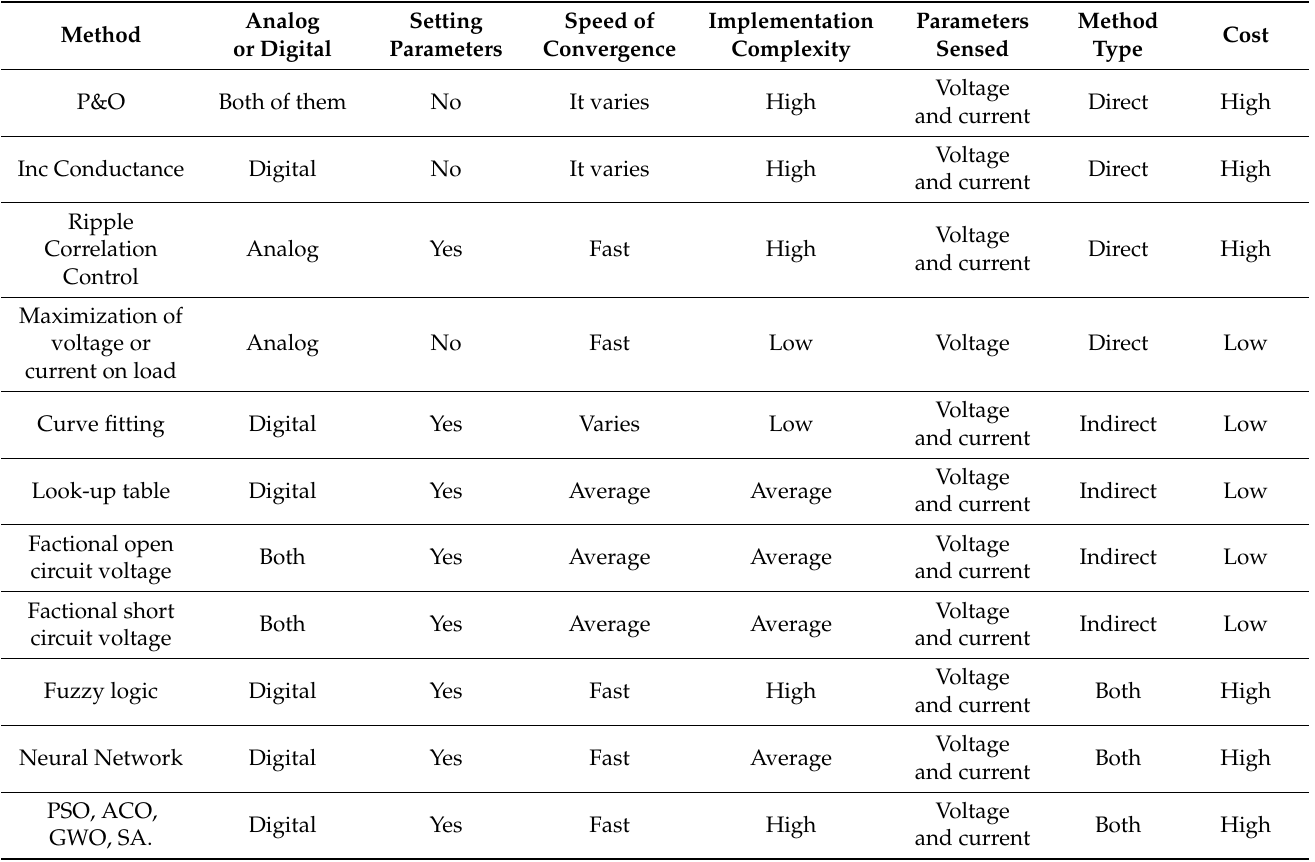
Table 1. Main characteristics of the maximum power point tracking